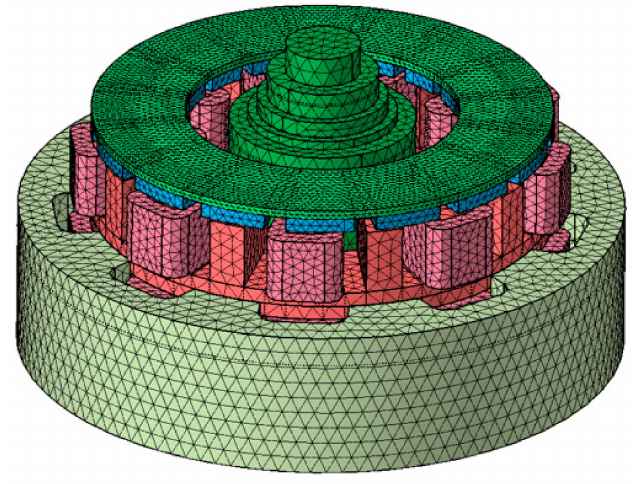
Figure 10. The meshed mechanical model of the AFPM